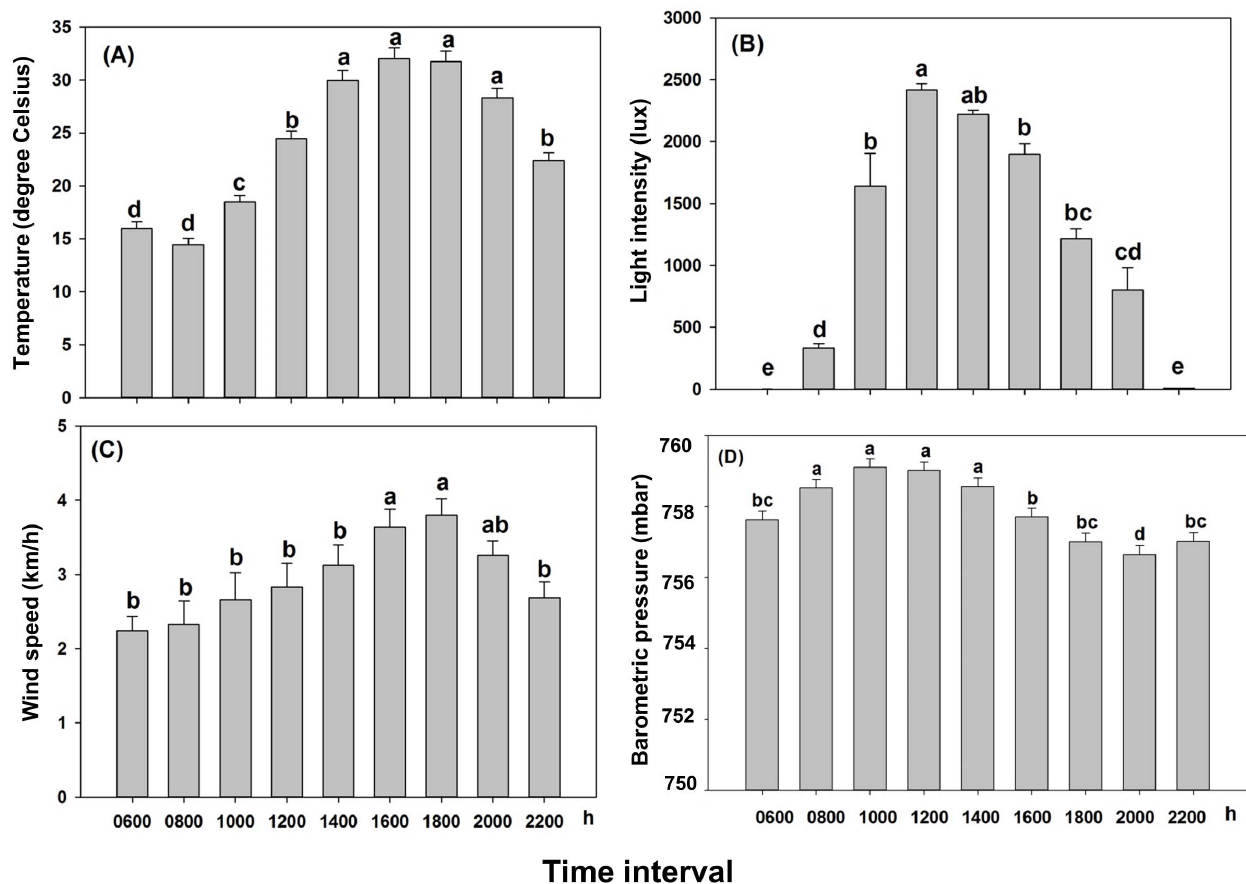
Figure 3. Environmental abiotic variables (mean + SE) at various time intervals of a day during the diurnal flight study of Pityophthorusjuglandis . (A) Temperature; (B) Light intensity (B); (C) Wind speed; and (D) Air pressure. Time intervals: 0600 h (2200 h of the previous day–0600 h the current day); 0800 h (0600–0800 h); 1000 h (0800–1000 h); 1200 h (1000–1200 h); 1400 h (1200–1400 h); 1600 h (1400–1600 h); 1800 (1600–1800 h); 2000 h (1800–2000 h); and 2200 h (2000–2200 h). Different lower-case letters above bars denote significant difference between time points with each variable ( a =0.05). N =134 days except for the time interval 0800 where N =133 days.